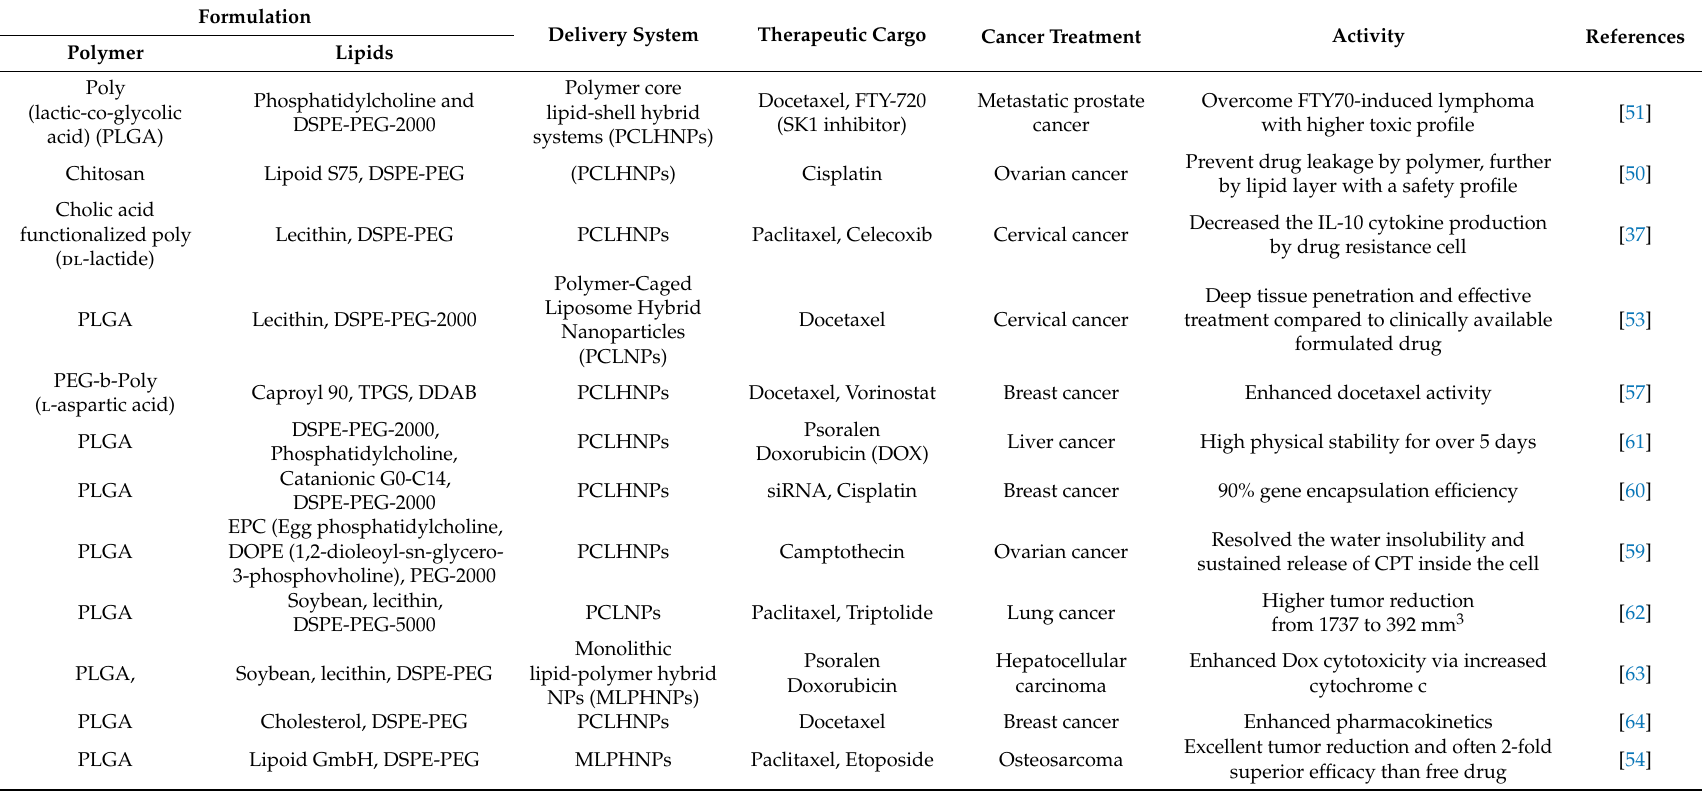
Table 1. Recently developed passive targeted anticancer therapies by